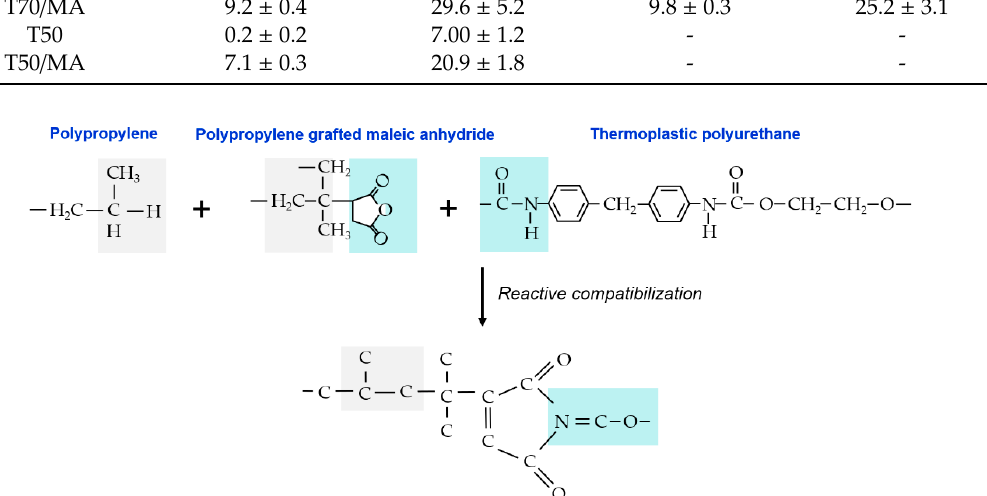
Figure 5. The reacted chemical groups in each material during the recycling processes.